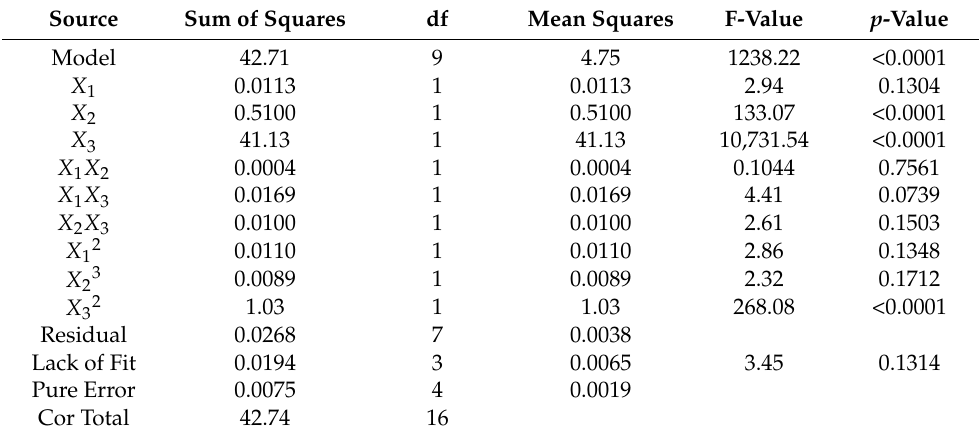
Table 3. Analysis of Variance (ANOVA) of the regression equation of CA against the growth of Y.